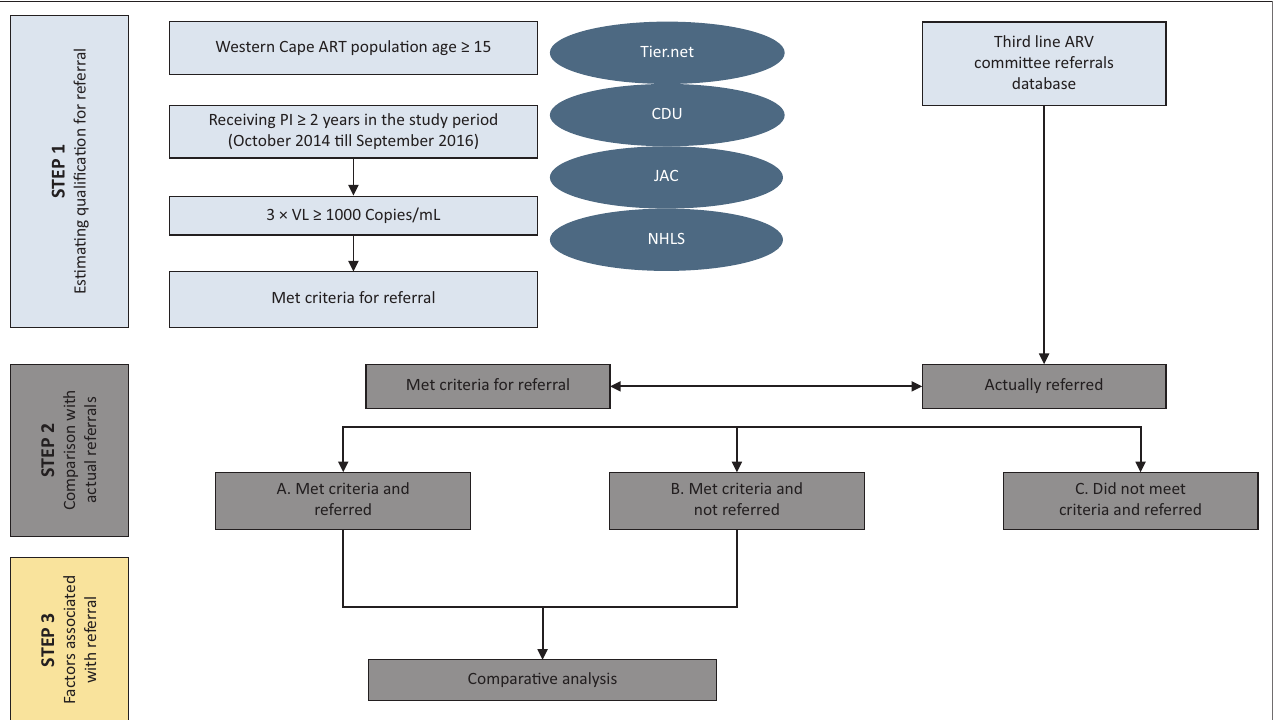
FIG URE 1: Graphic representation of study